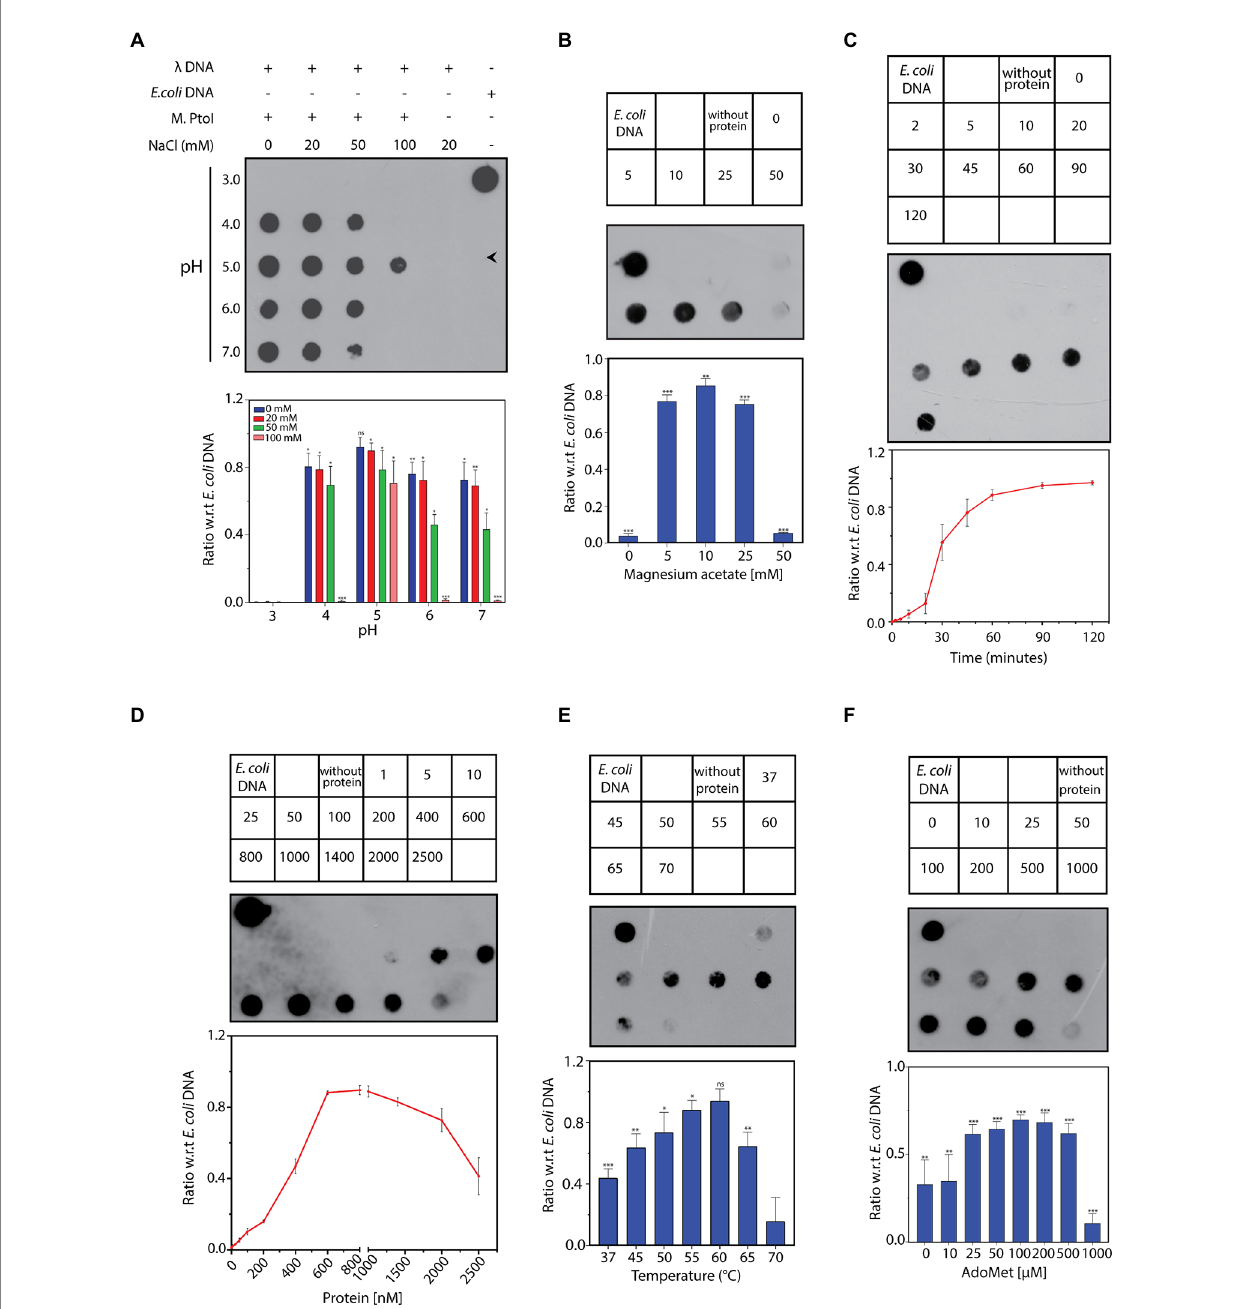
FIGURE 7 (A–F) Dot blot analyses of methylation assays performed with M.PtoI. Assays were performed with 1 μ g lambda DNA substrate, in Tris-acetate based buffer (pH 5) carrying 10 mM magnesium acetate, 100 μ M S-adenosyl methionine (AdoMet), 20 mM sodium chloride, and 1.4 μ M M.PtoI, at 55 ° C, unless otherwise specified. 1 μ g E.coli genomic DNA was used as control on every dot blot. Upper panels in each figure: loading scheme of dot blot. Middle panel: Dot blot of assay. Lower panel: quantification of signals from methylation reactions as a ratio of E.coli genomic DNA signal, done using ImageJ software. Data represent average of three experiments. Error bars represent standard deviation. Student’s two-tailed t- test was applied, * p < 0.05, ** p < 0.005, *** p < 0.0005, ns-not significant. (A) Reaction as a function of pH and salt concentration: Activity was assayed over pH 3–7 in presence of 0–100 mM sodium chloride, using 1.4 μ M M.PtoI at 55 ° C for 1 h. (B) Reaction as a function of magnesium ion concentration: Activity was assayed over 0–50 mM magnesium acetate, using 1.4 μ M M.PtoI at 55 ° C for 1 h. Numbers in the boxes above the blot represent magnesium acetate concentrations (mM). Reaction without protein had 10 mM magnesium acetate. (C) Progress curve of the reaction: Activity was monitored over 2–120 min using 1.4 μ M M.PtoI, at 55 ° C. Numbers in the boxes above the blot represent incubation time (min). Reaction without protein was incubated for 120 min. (D) Reaction as a function of enzyme concentration: Activity was assayed with 1–2,500 nM M.PtoI, at 55 ° C for 45 min. Numbers in the boxes above the blot represent enzyme concentrations (nM). (E) Reaction as a function of temperature: Activity was assayed over 37–70 ° C, using 600 nM M.PtoI for 45 min. Numbers in the boxes above the blot represent reaction temperature. Reaction without protein was incubated at 55 ° C. (F) Reaction as a function of AdoMet concentration: Activity was assayed over 0–1,000 μ M S-adenosyl methionine (AdoMet), using 400 nM M.PtoI at 55 ° C for 1 h. Numbers in the boxes above the blot represent AdoMet concentrations ( μ M). Reaction without protein had 100 μ M